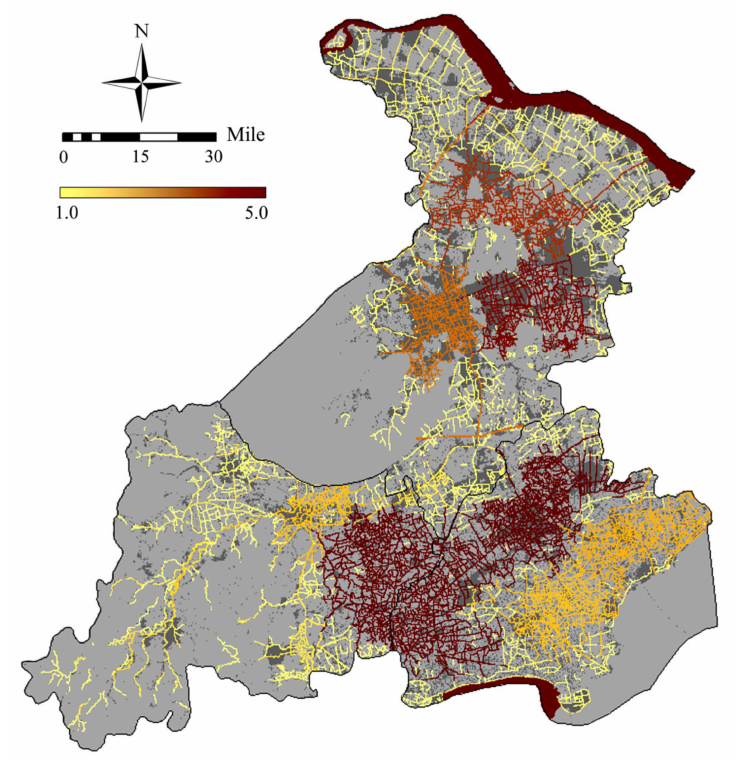
Figure 6. Mapping of MESC indexes of linear water spaces in the Hu-Su-Jia area. Mega river cluster